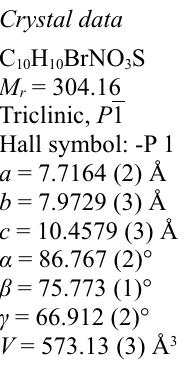
The partial packing figure ( PLATON : Spek, 2003) which shows that intermolecular H-bonds form the ring motifs. 6-Bromo-1-ethyl-1 H -2,1-benzothiazin-4(3 H )-one